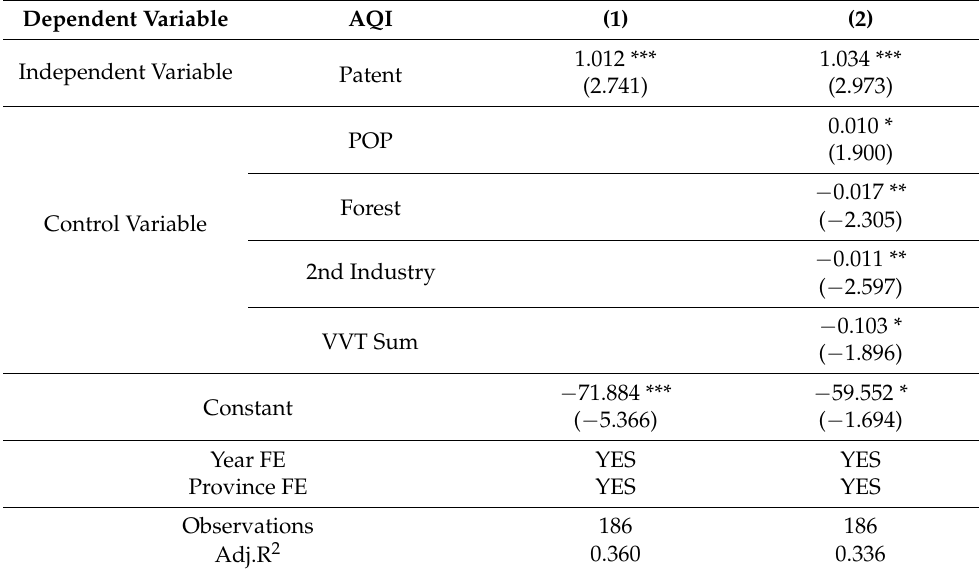
Table 5. Innovation and AQI—baseline